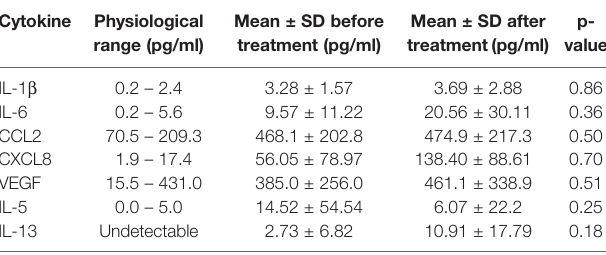
Undetectable The analysis was performed by paired Student ’ s t-test for normally distributed samples or Wilcoxon matched-pairs signed rank test for not-normally distributed samples cumulating data from 24